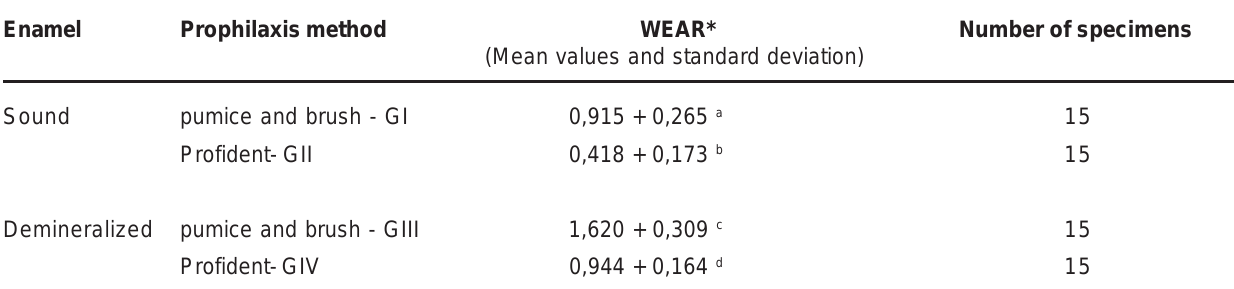
TABLE 1- Mean wear value ( µ m) and standard deviation of the studied groups